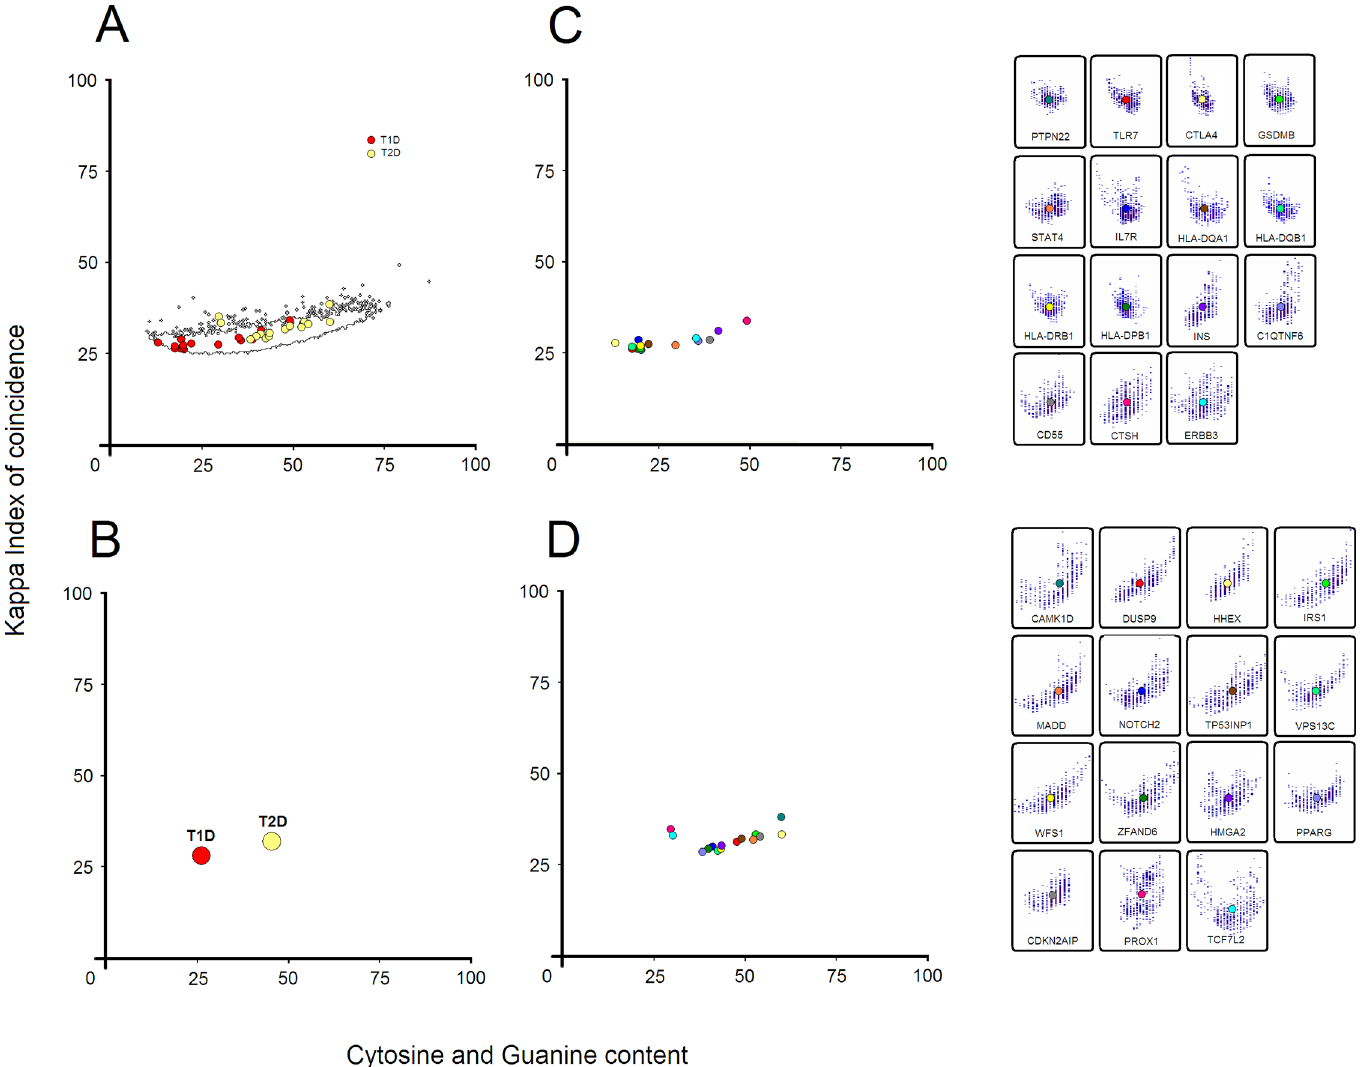
Fig 2. Distribution of T1D and T2D gene promoters. (A) overlapping distribution of T1D and T2D gene promoters on a genome-wide distribution of 8,515 Homo sapiens promoters, (B) mean distribution of T1D and T2D gene promoters, (C) distribution of T1D gene promoters, (D) distribution of T2D gene promoters. Each circle represents the center of weight from a promoter pattern and the circle color is associated with a corresponding gene promoter. doi:10.1371/journal.pone.0137950.g002 PLOS ONE | DOI:10.1371/journal.pone.0137950 September 17,